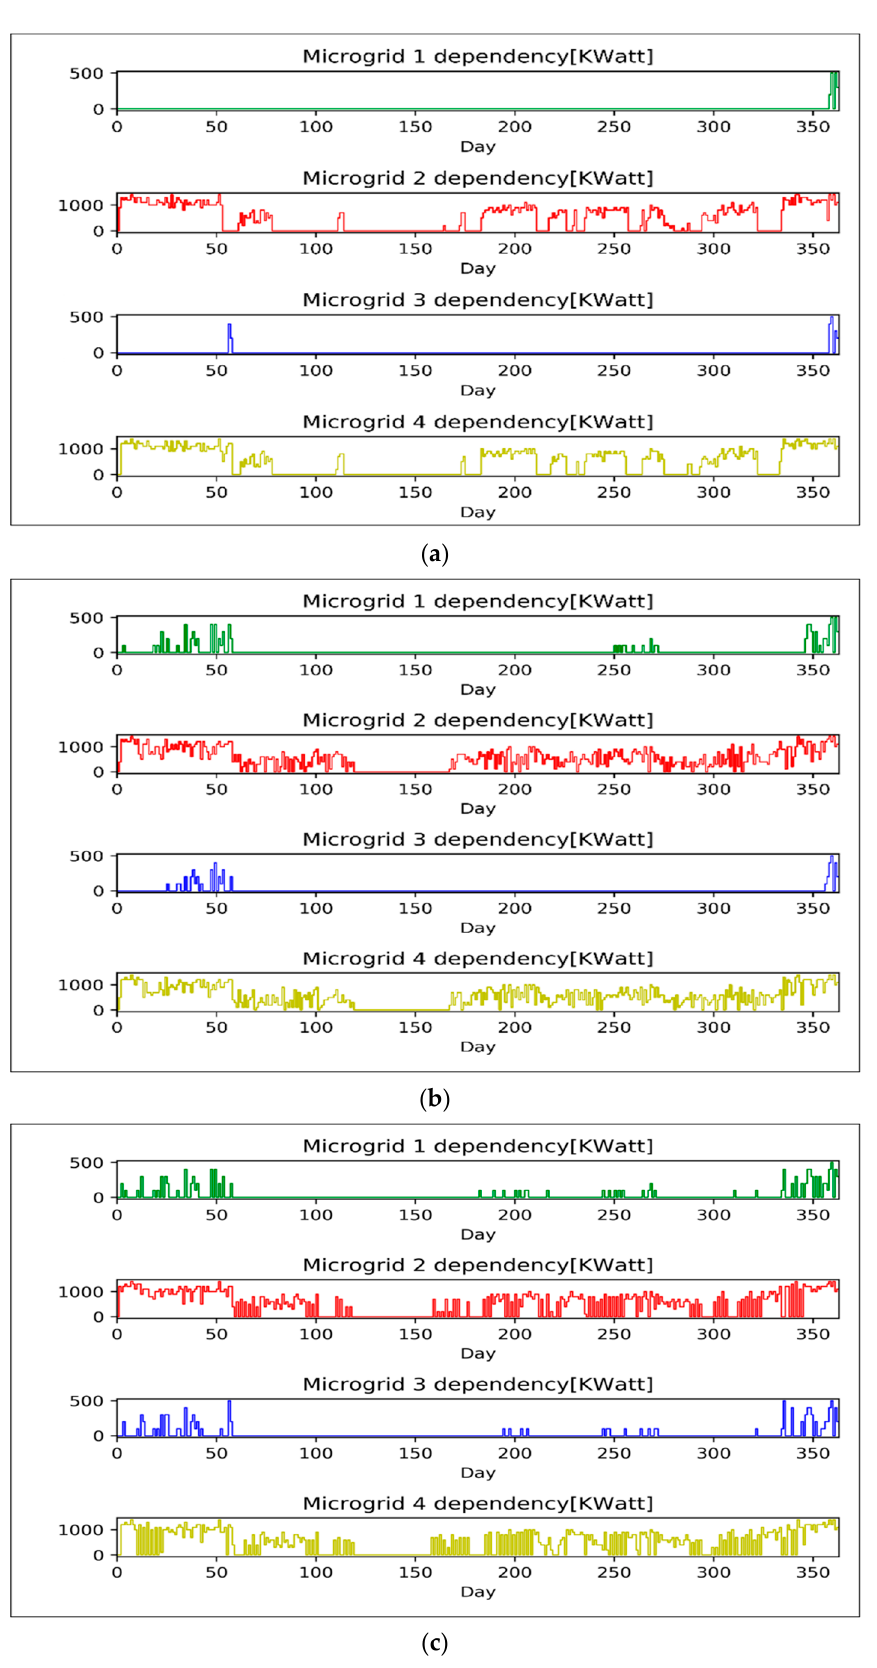
Figure 5. Energy quantity received from the main grid by each MG in the optimized model; ( a ) proposed ETS ( b ) EFD-ETS ( c ) CCPV-ETS.